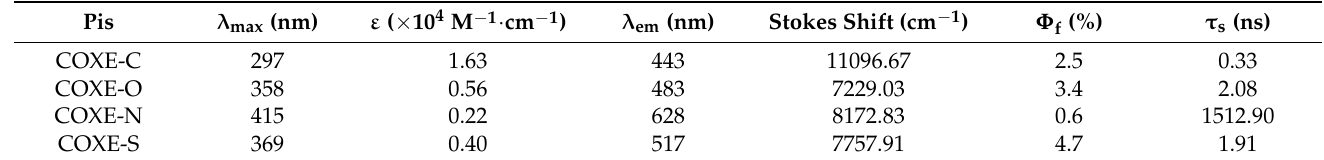
Figure 3. ( a ) UV − Vis absorption spectra and ( b ) fluorescence emission spectra for COXEs in acetoni- trile at room temperature.